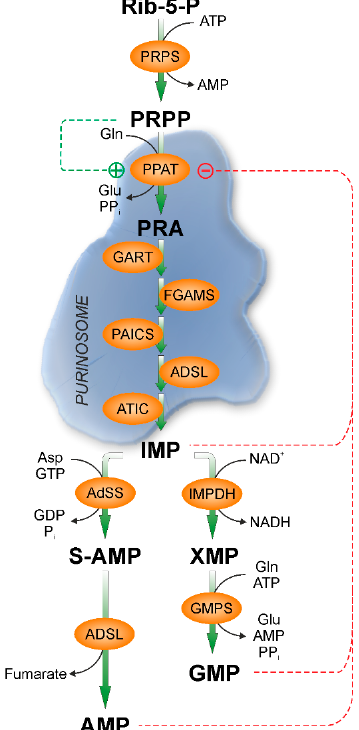
Figure 1. Purine de novo synthesis and its regulation. PRPP (5-phosphoribosyl-1-pyrophosphate) is